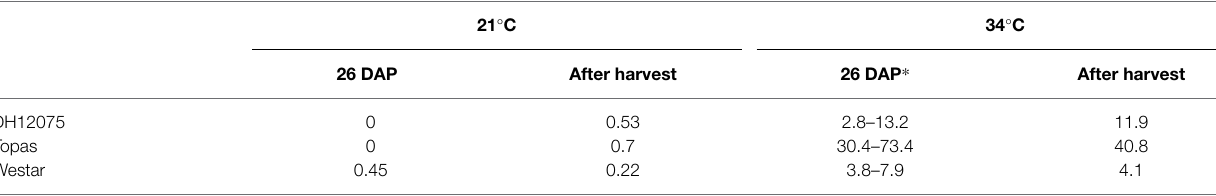
TABLE 3 | Comparison of pre-harvest germination of mature and dry seeds (percentage of total seeds for one